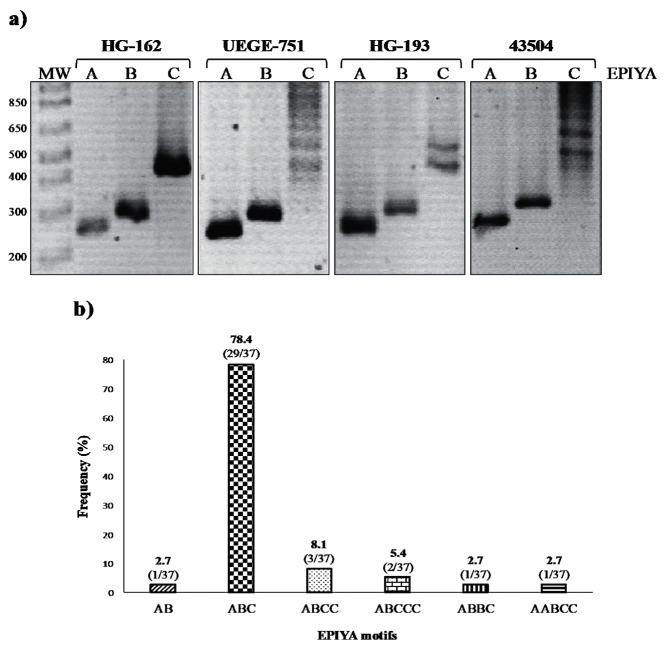
Characterization of EPIYA motifs. (a) Representative gel electrophoresis of PCR products of EPIYA motifs of strains: HG-162 (EPIYA-ABC), UEGE-751 (EPIYA-ABCCC) and HG-193 (EPIYA-ABCC). Strain ATCC43504 (EPIYA-ABCCC) was used as a positive control. Lanes: MW, 100 bp molecular weight marker; A, EPIYA-A motif (~256 bp); B, EPIYA-B motif (~306 bp); and C, EPIYA-C motif (first, 501 pb; second, ~650 pb; and third, >650 bp). (b) Frequency of CagA EPIYA motifs of H. pylori strains from patients with chronic gastritis.